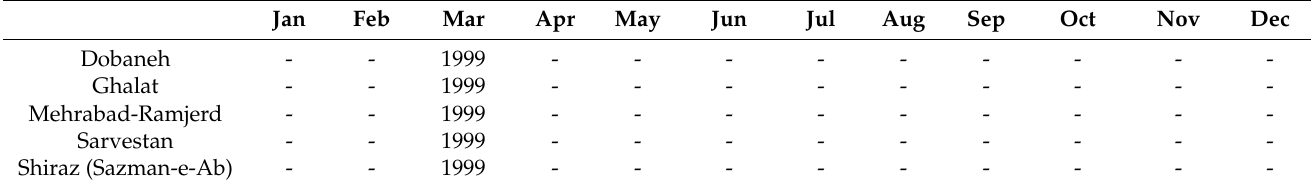
Table 4. Changing points detected in the monthly rainfall time series of selected stations.